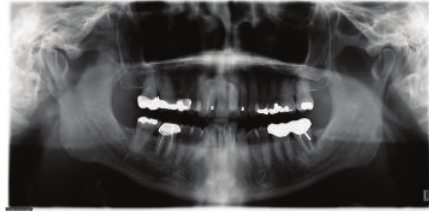
Figure 1: Initial panoramic radiograph.